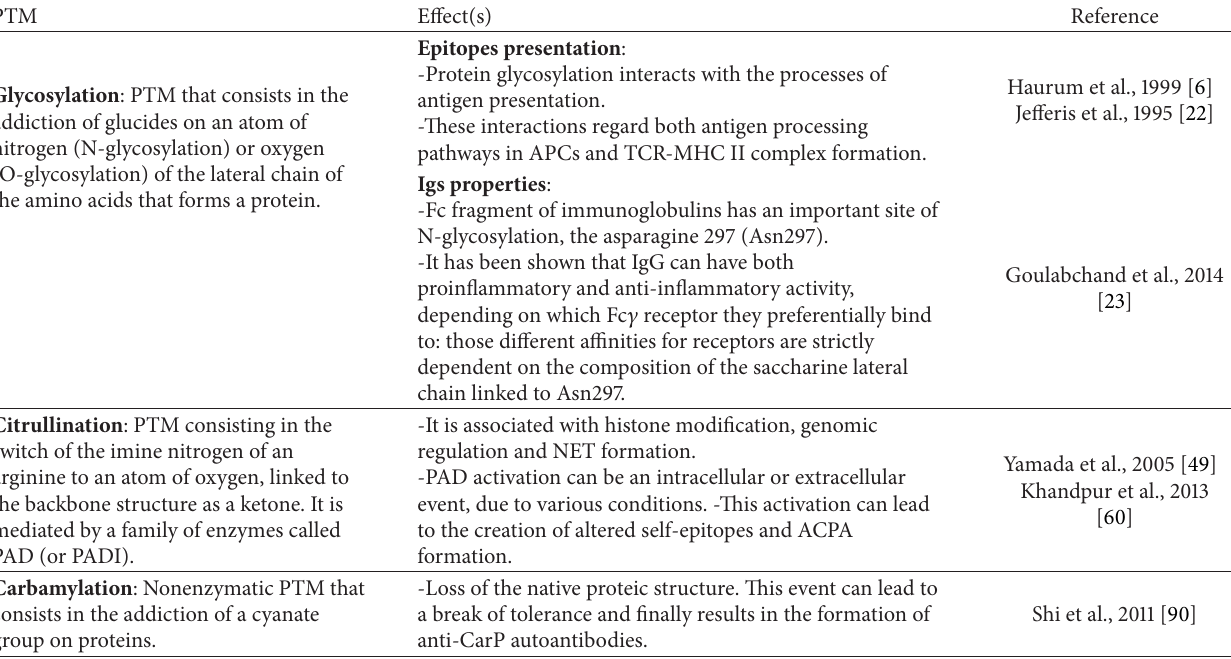
Table 1: Summary of some posttranslational modifications in rheumatoid